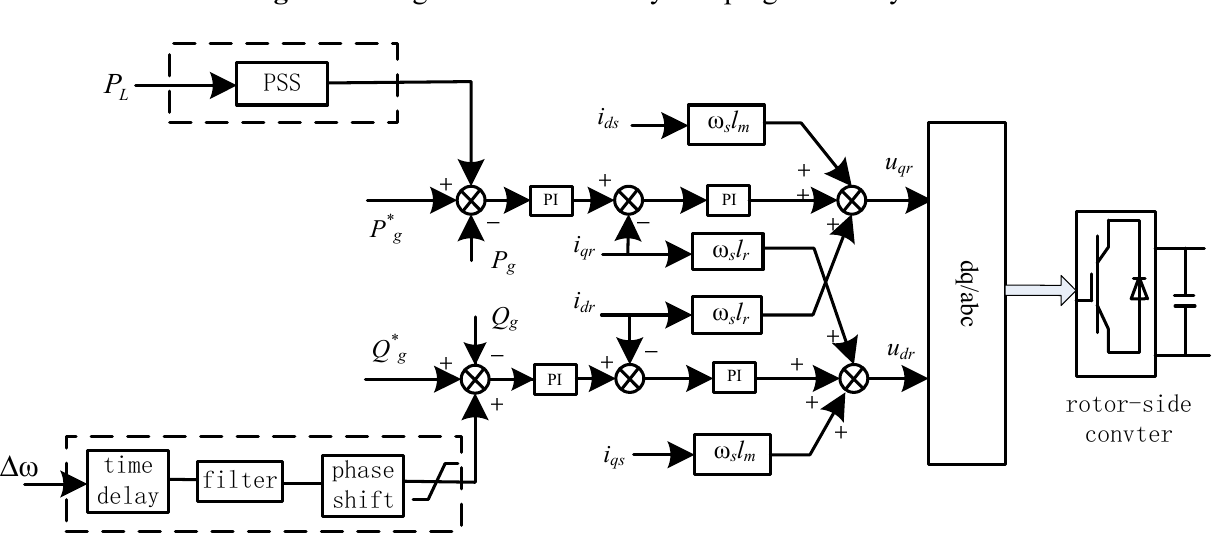
Figure 4. Diagram of the auxiliary damping control